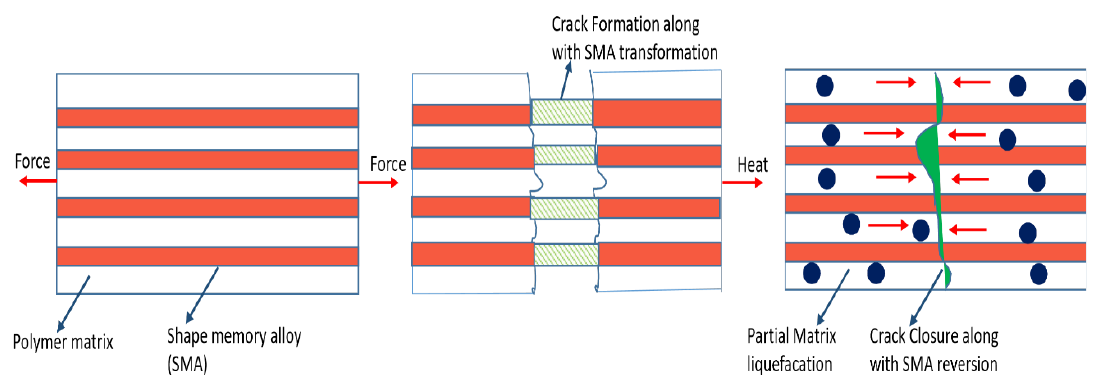
Figure 11. Liquid-aided healing of MMCs reinforced with SMA [141].